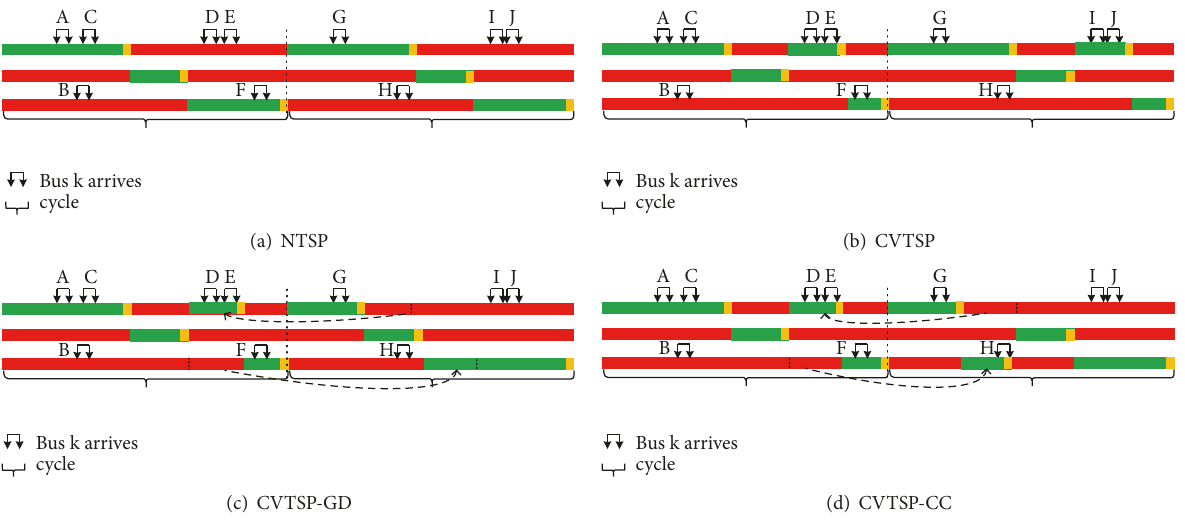
Figure 3: Timing plans for NTSP, CVTSP, CVTSP-GD, and